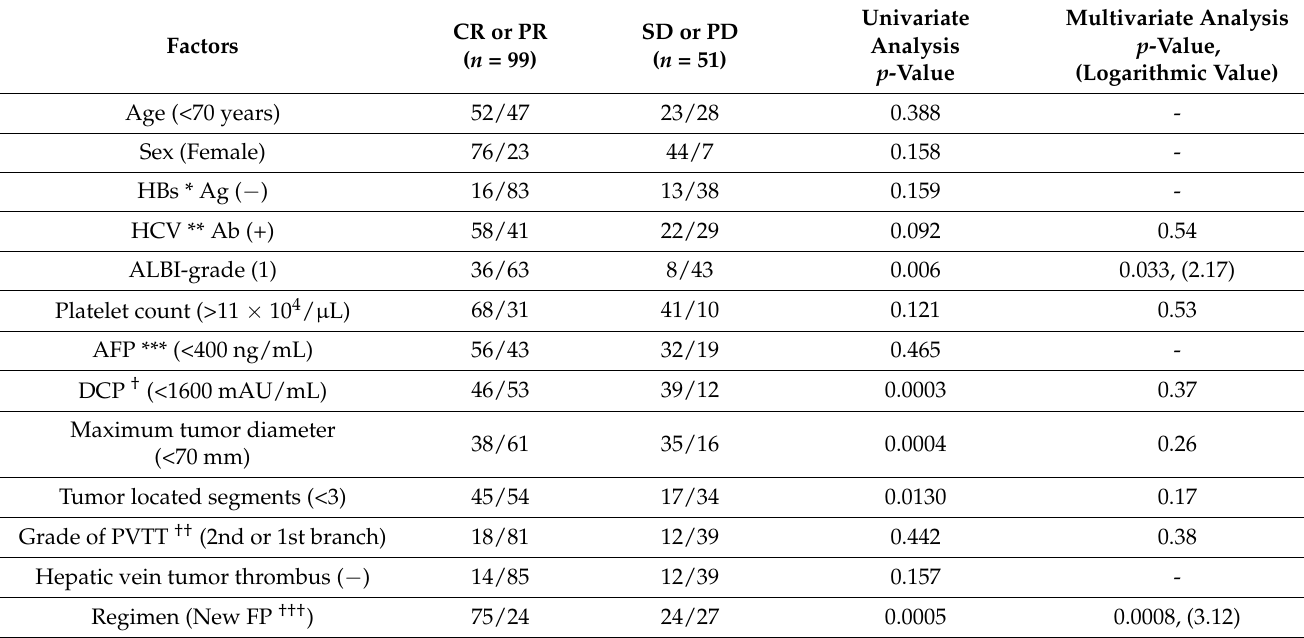
Table 4. Univariate and multivariate analysis of the factors associate with the better therapeutic effects of either LFP or New FP ( n =